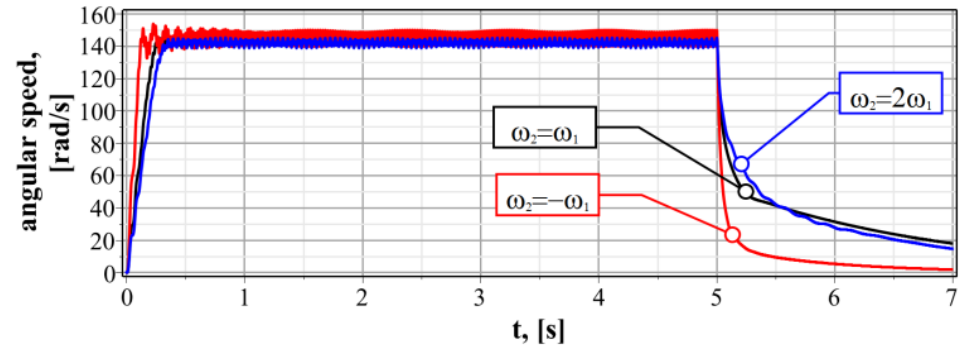
Figure 4. Time series of the electric motor’s shaft angular speeds under different synchronization conditions of the unbalanced rotors.